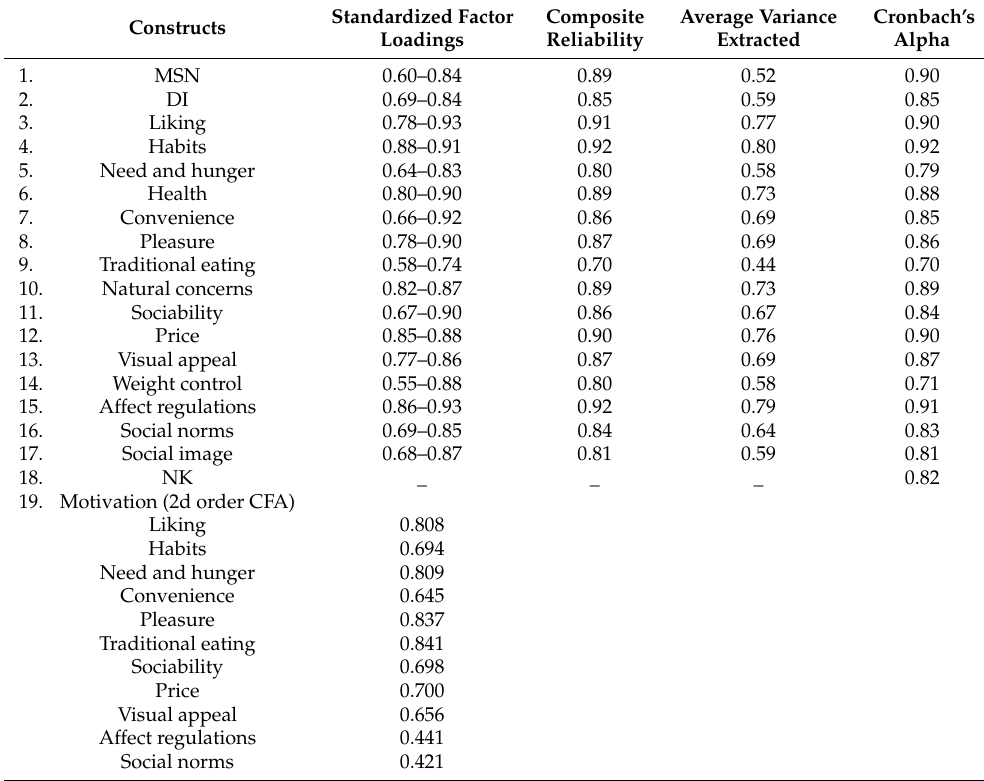
Table 2. Standardized factorial CFA loadings in the first and second order, composite reliability estimates, and average variance extracted ( n = 807).